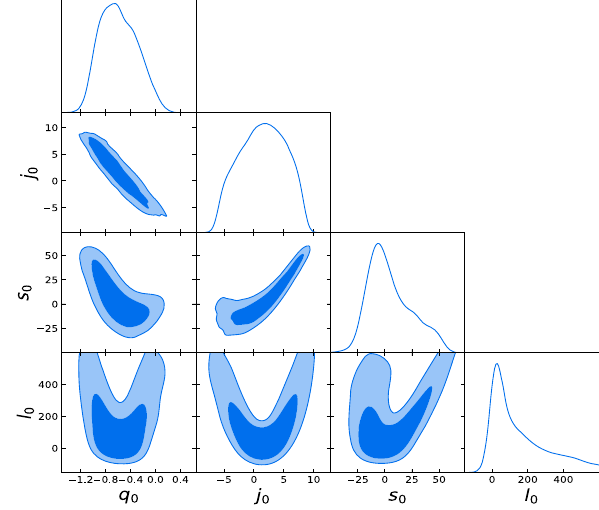
Fig. 1 Constraints on cosmographic parameters in the 4 order from the JLA compilation for redshift z <